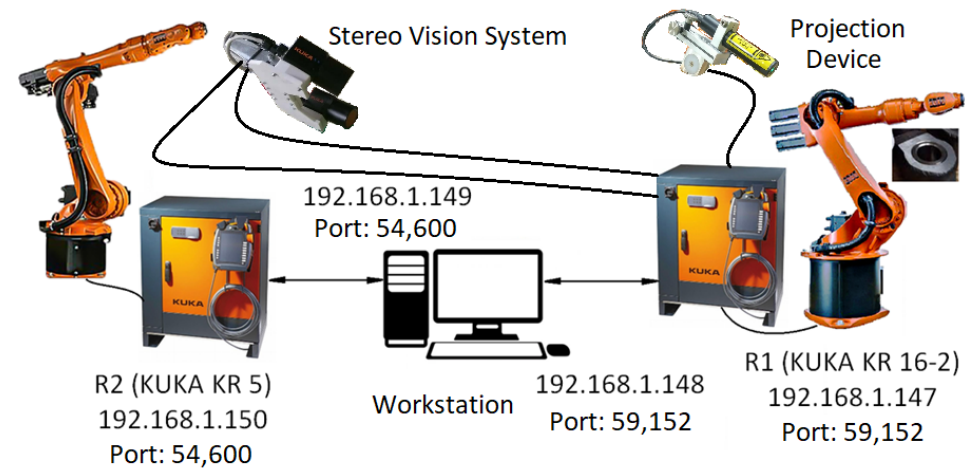
Figure 3. The simplified algorithm for controlling the robots during measurement.